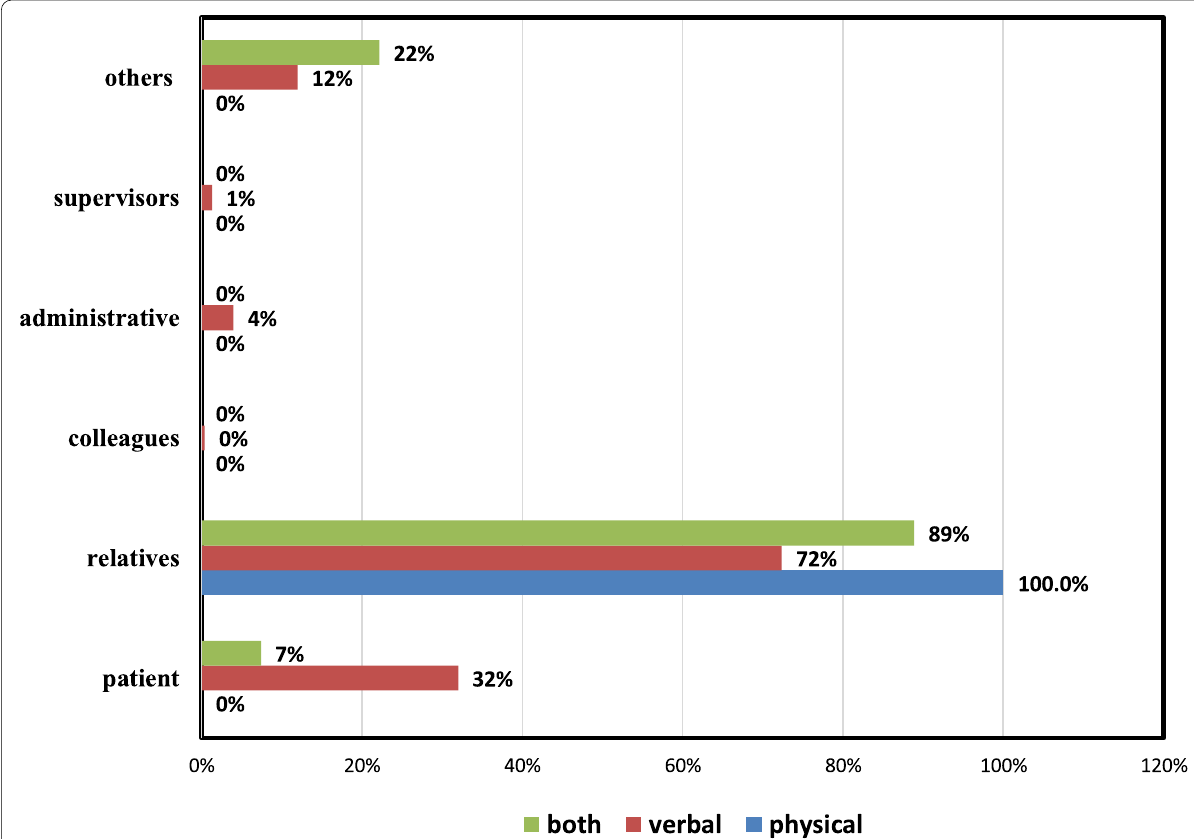
Fig. 4 The frequency of the type of violence against HCWs according to the perpetrator of the violent